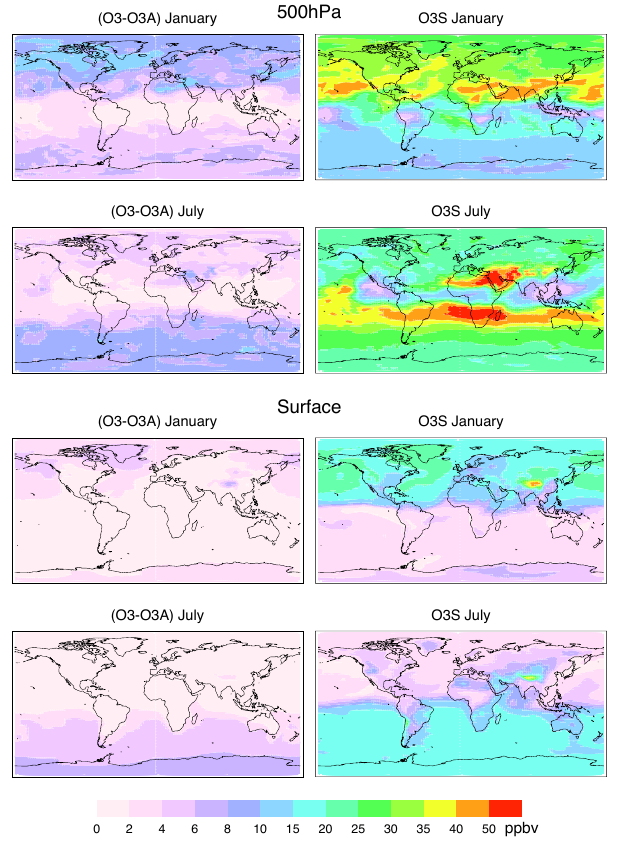
Fig. 8. Stratospheric ozone contribution from the tagged NO method (left) and from the stratospheric ozone tracer, O3S (right), at 500hPa (top) and the surface (bottom).